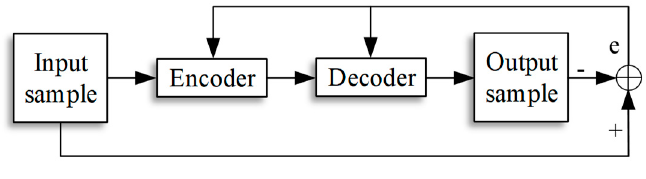
Figure 3. AE model structure.